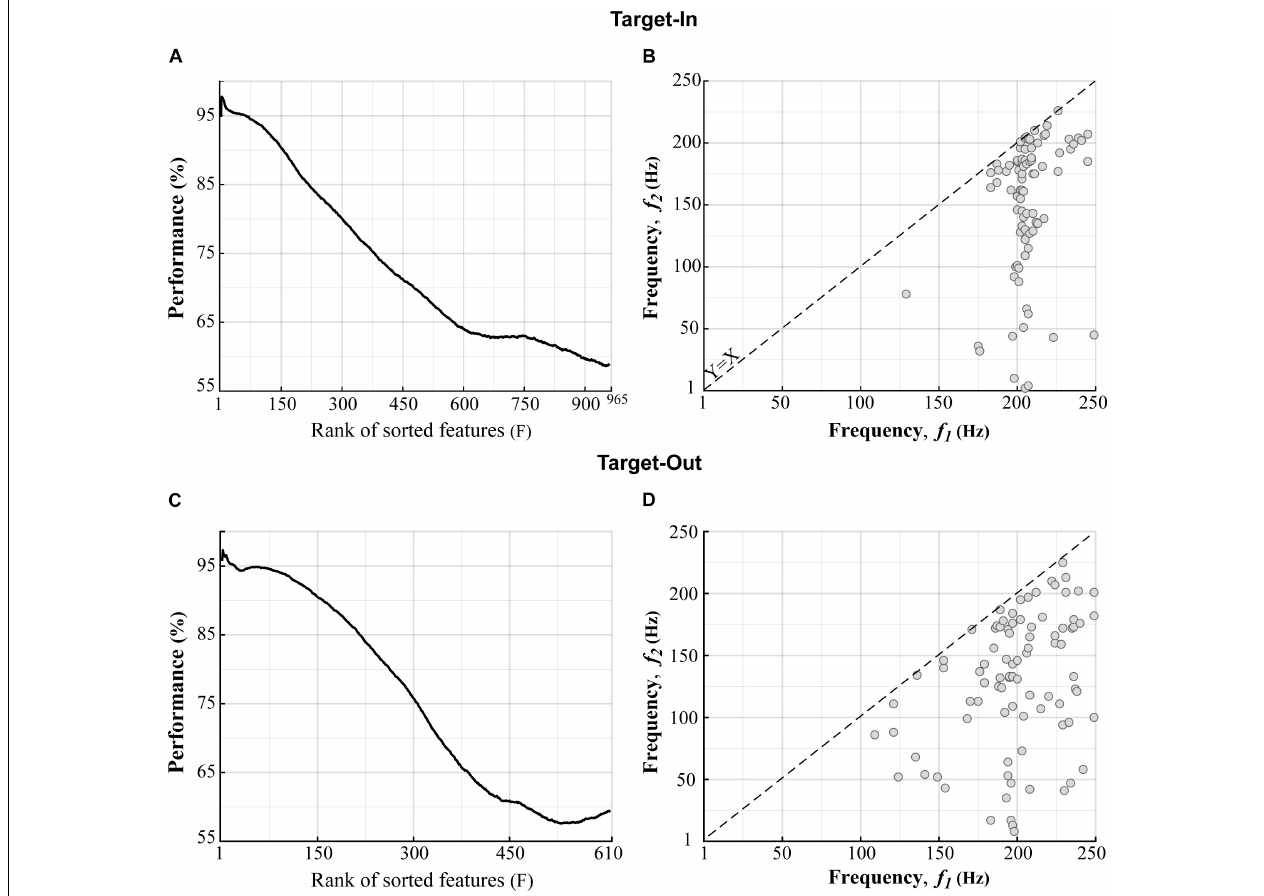
FIGURE 3 | Distributions of the bifrequency components provided high classification performance in decoding the fast and the slow trials. (A,C) The bifrequency components (features) in the Target-In and the Target-Out conditions, respectively, which were sorted based on the decoding performance in descending order. (B,D) Distributions of the bifrequency components in panels (A,C) , respectively, which provided performance of over 90% in decoding the fast and the slow trials. (B,D) show 85 and 89 bifrequency components for the Target-In and the Target-Out conditions, respectively. We did not analyze the upper bound of the X = Y -axis in panels (B,D) because of the symmetric property of the bicoherence. X - Y axes indicate the center bound of frequency bands in panels (B,D)